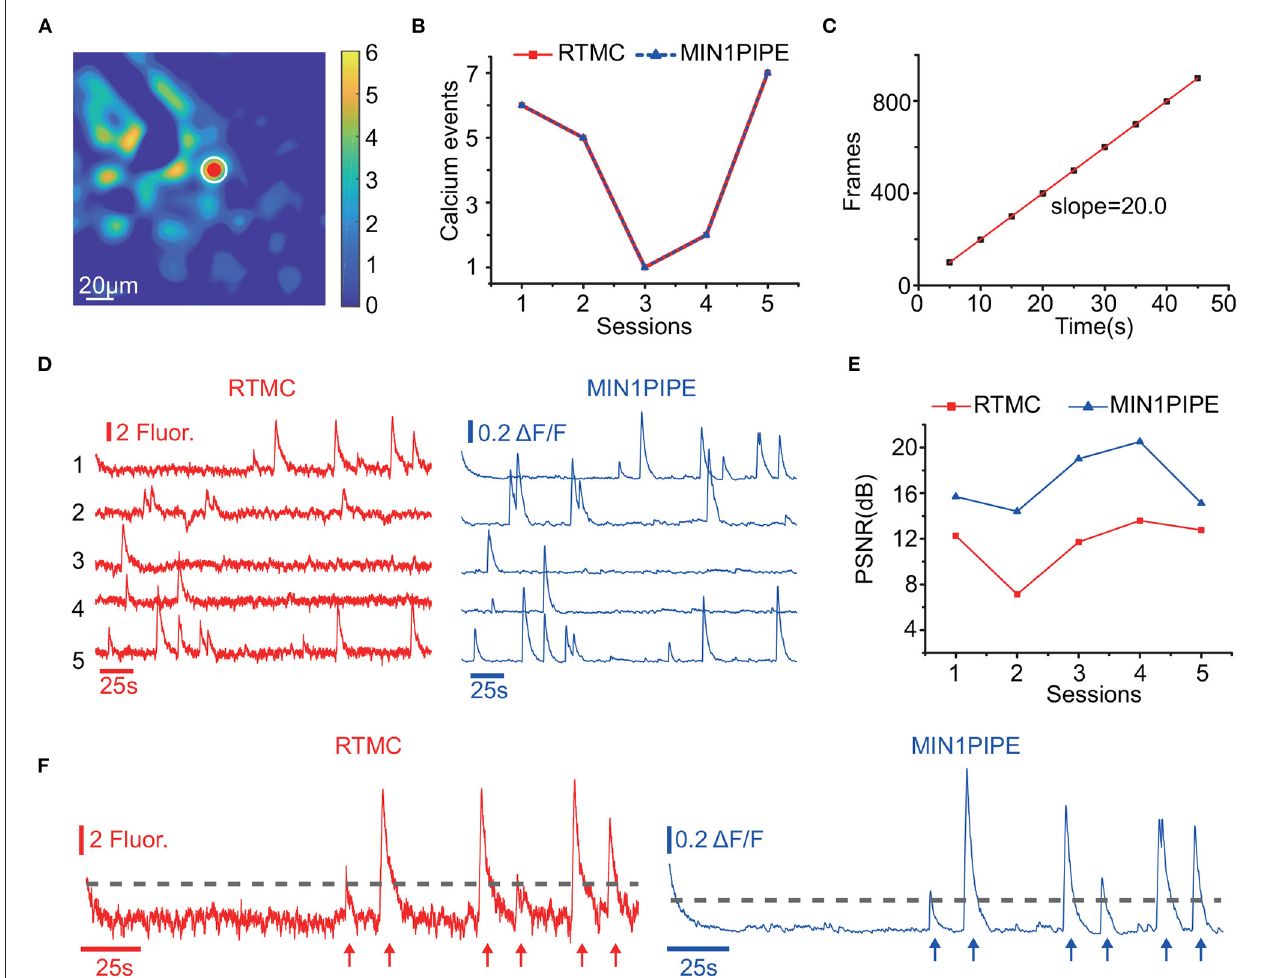
FIGURE 7 | Calcium event detection in real-time with RTMC and offline with MIN1PIPE. The data were collected at 20 Hz. (A) : The target neuron (red dot) and local background (white circle). (B) : Number of detected calcium events in 5 sessions (each session lasts 250 seconds). Real-time detection was implemented by RTMC and manual labeling (red square and solid line), while offline detection was implemented by MIN1PIPE (blue triangle and dashed line). (C) : Cumulative number of frames received every 5 seconds while RTMC is running with motion correction enabled. The linear fit represents the equivalent frame rate. (D) : The traces extracted in real-time by RTMC and offline by MIN1PIPE in 5 sessions. (E) : The peak signal-to-noise ratio (PSNR) of the traces extracted in real-time by RTMC and offline by MIN1PIPE. (F) : Enlarged example of the trace of the first session in (D) . The dotted line indicates the threshold for calcium events, and the arrows indicate the temporal position of the